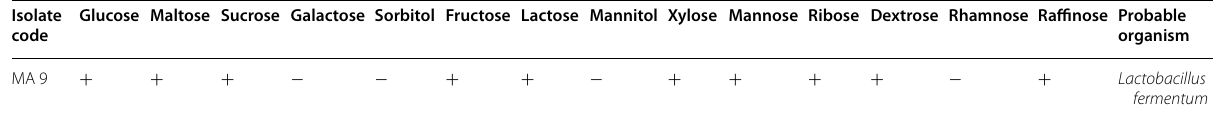
Table 4 Sugar fermentation pattern of Isolate MA9 Isolate code MA , positive; , negative + −